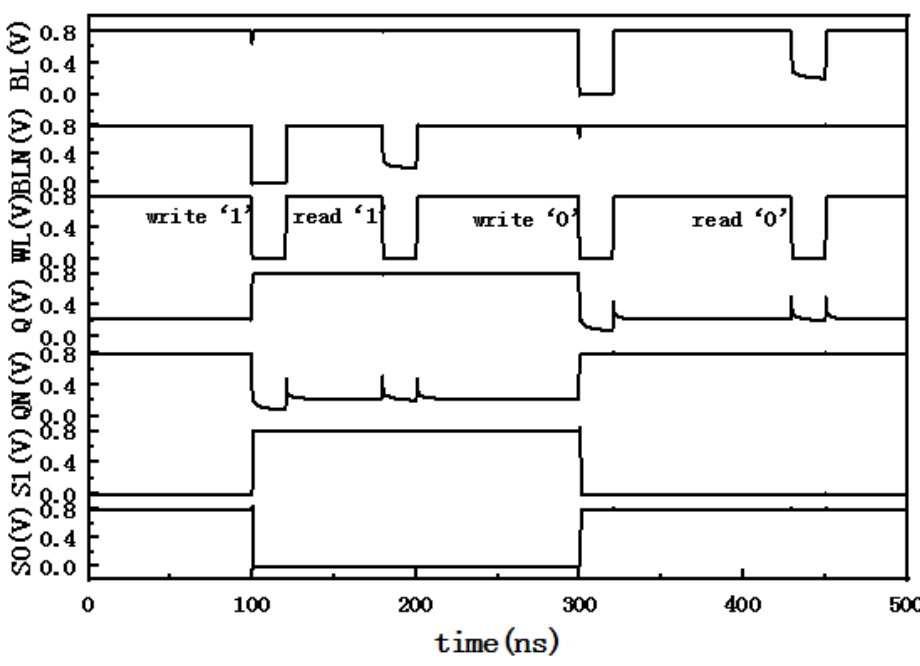
Figure 3. Write and read operation of PP10T.